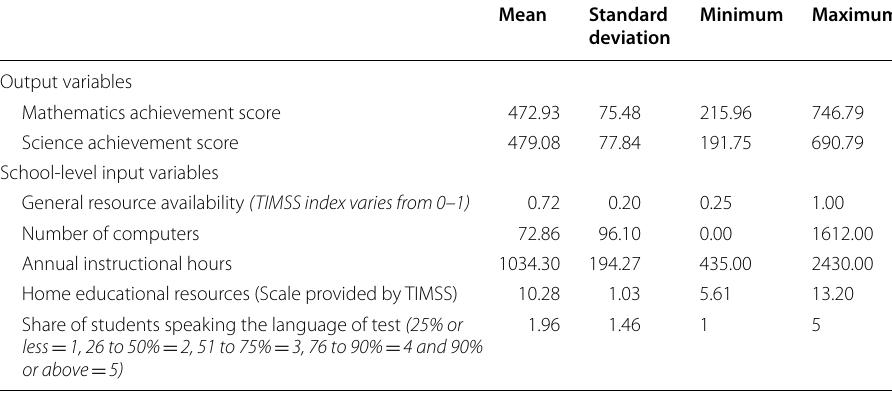
Table 3 First stage summary